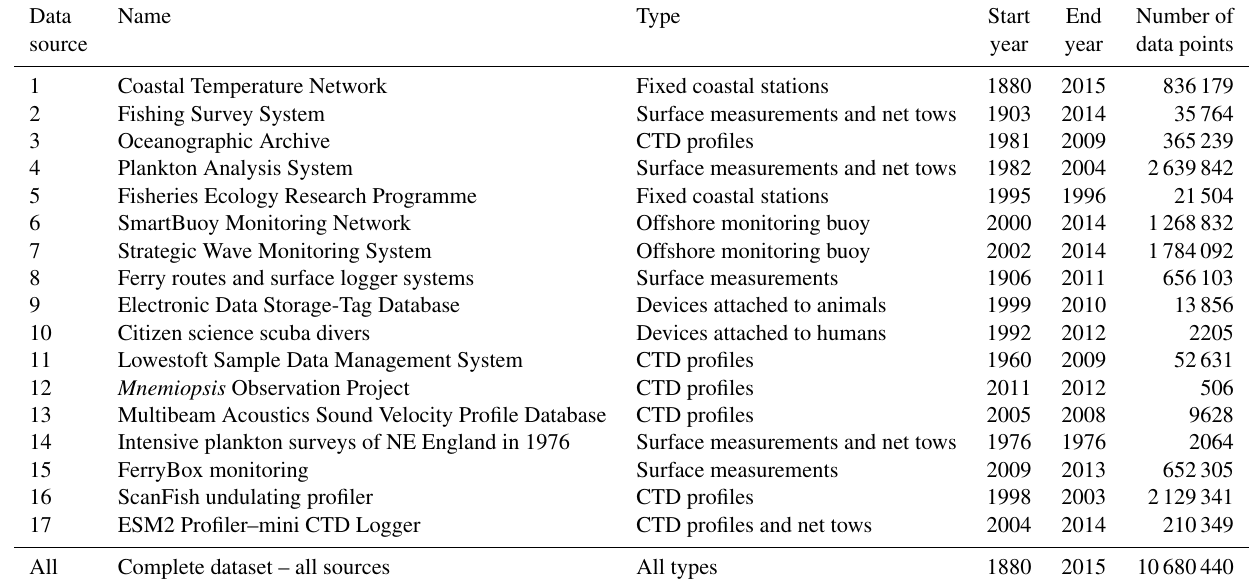
Table 1. Summary metadata for the 17 seawater temperature sources.